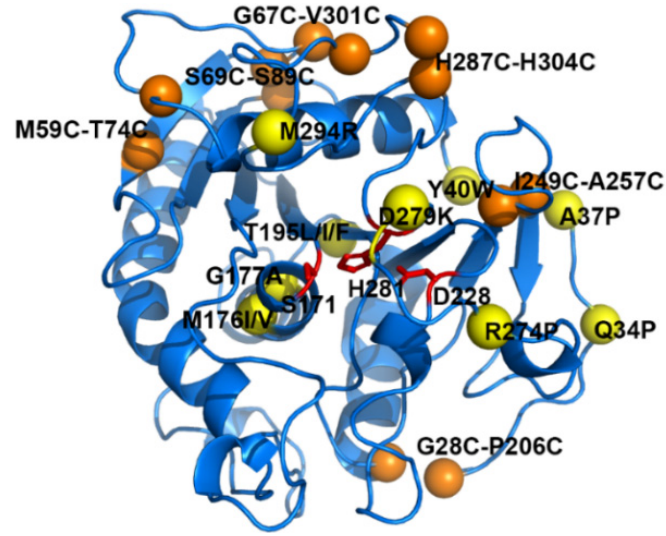
Figure 1. Location of stabilizing mutations in SMG1 (PDB ID: 3UUE). Yellow spheres represent effective single-point mutations and orange spheres represent effective disulfide bonds. The catalytic triad (S171, D228, and H281) is shown as red sticks. Table 2. The melting temperatures of beneficial disulfide bond mutants.